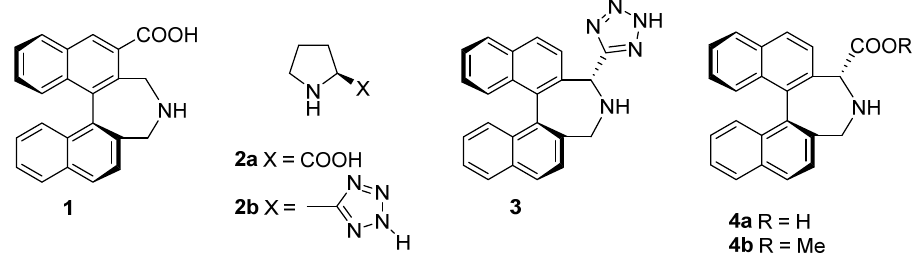
Figure 1. 1,1 ′‐ Binaphthylazepine and proline based chiral